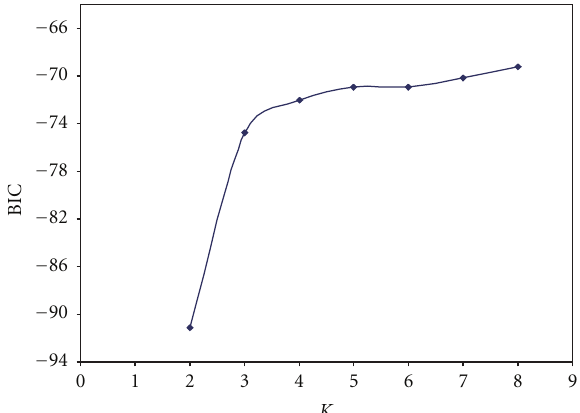
Figure 6: Plot of BIC values for clinical PET volumes of nonsmall cell lung cancer patient, scaled by a factor of 1000.